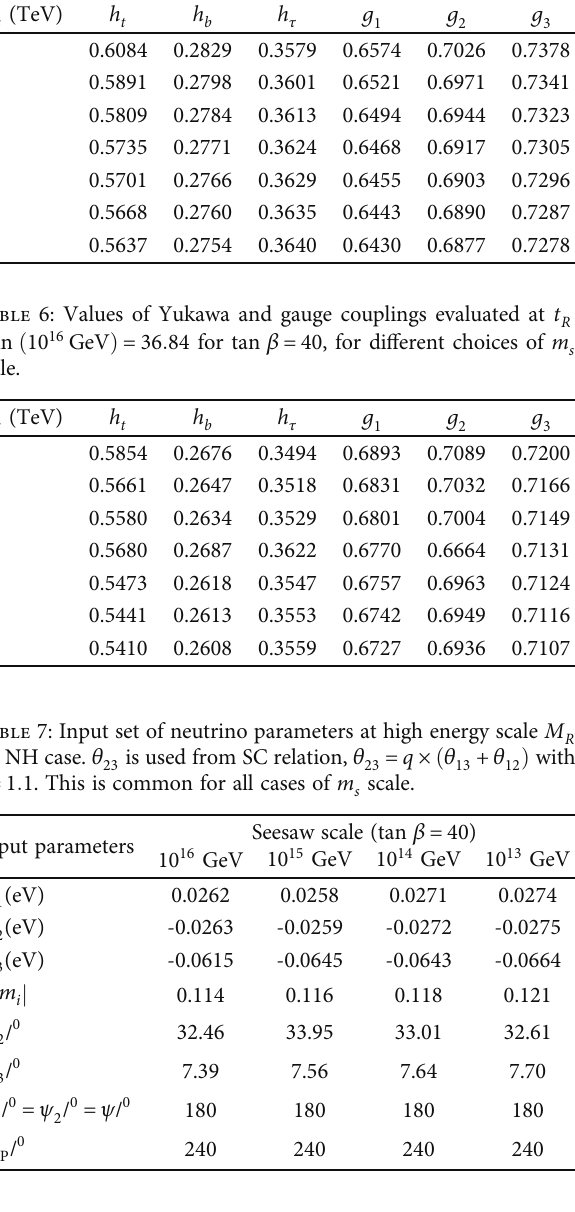
Table 8: Input set of neutrino parameters at high energy scale M = ln ð 10 15 R scale. s